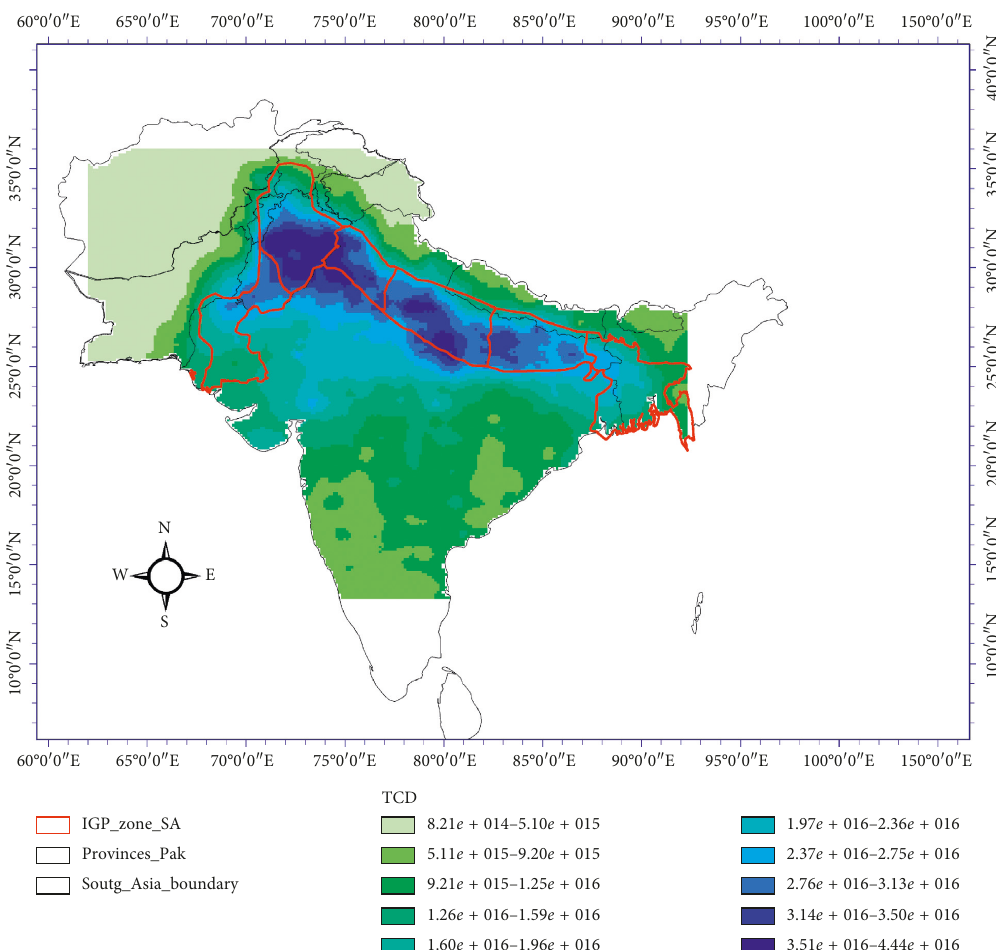
2 ) for years 2004–2011 over South Asia. Red polygons indicate the subregions of the Figure 2: Average map of NH 3 columns (molecules/cm Indo-Gangetic Plain